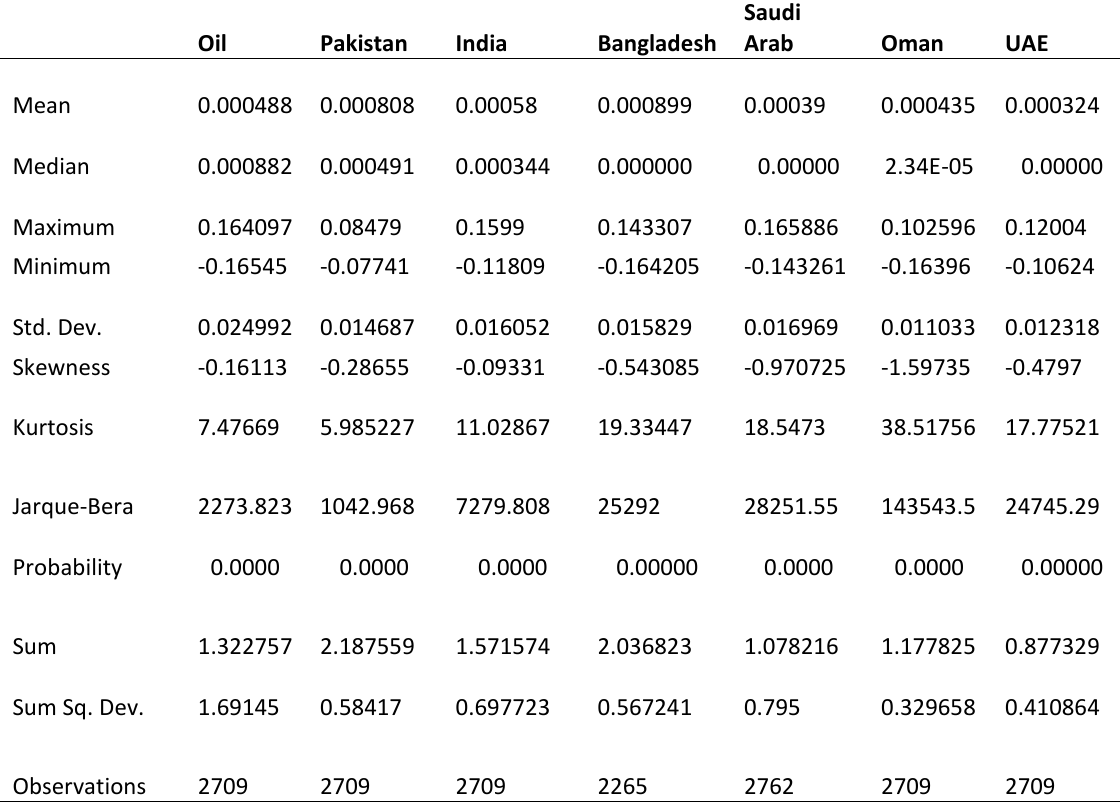
Table 3. Descriptive statistics of returns of oil market and stocks returns of oil importer and exporter